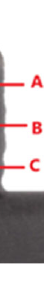
Figure 5. Reference lines of measurement of hardness.